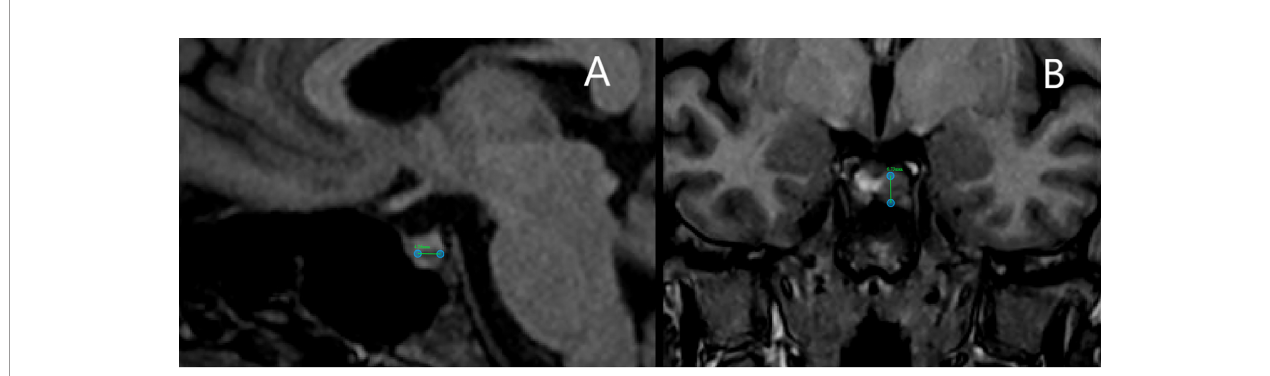
FIGURE 2 | Magnetic resonance imaging scans of bilateral inferior petrosal sinus sampling case patient. (A) Scan before bilateral inferior petrosal sinus sampling shows a pituitary tumor of 4.6 mm in diameter. (B) Scan shortly before surgery shows an increase in tumor volume with a diameter of 6.7